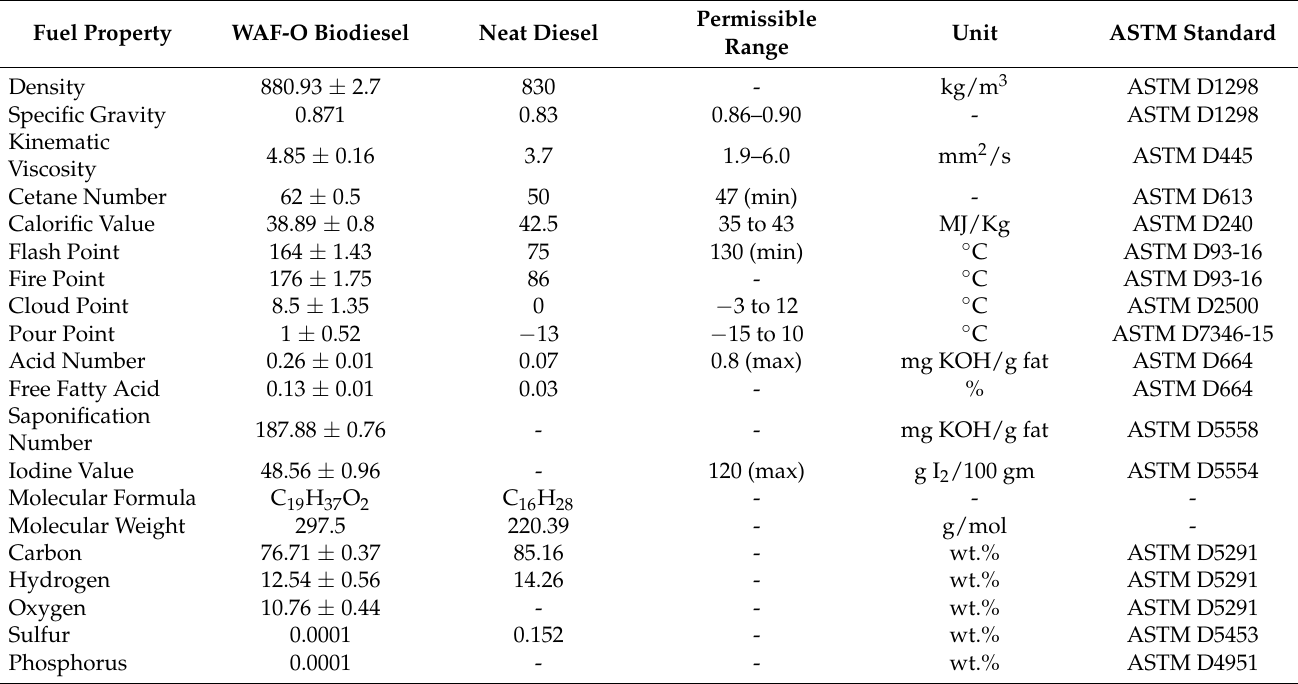
Table 3. Fuel properties of WAF-O biodiesel and neat diesel.